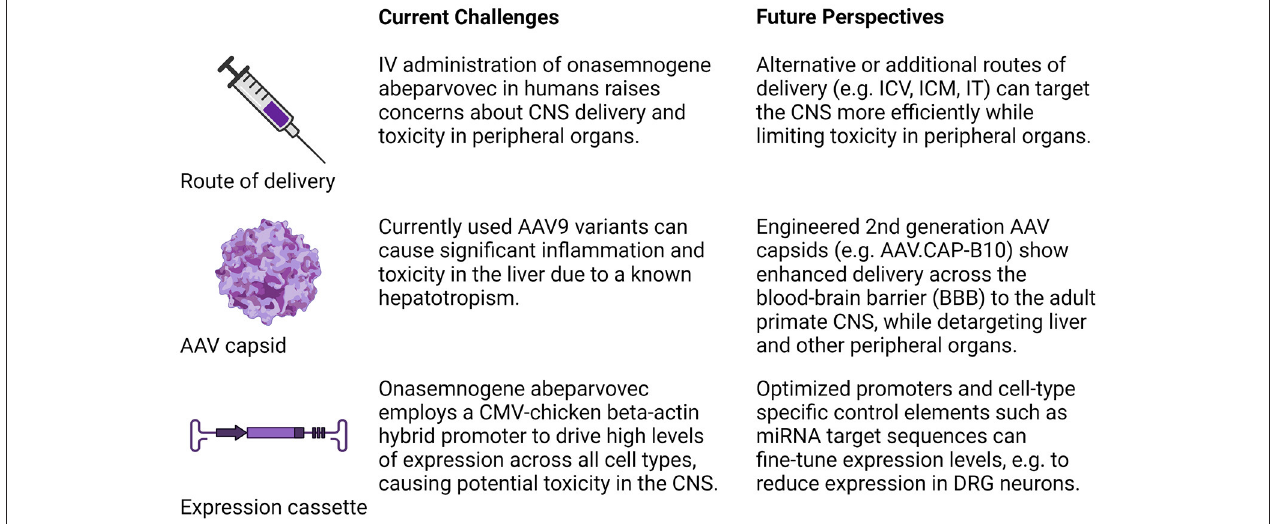
FIGURE 1 | Strategies for increasing therapeutic transduction efficiency and reducing toxicity. Concerns raised by recent studies and future strategies to address these challenges as they relate to the route of administration, the AAV serotype/capsid, and expression construct are summarized. IV, intravenous; ICV, intracerebroventricular; ICM, intracisterna magna, IT, intrathecal; CMV, cytomegalovirus; miRNA, micro-RNA. Figure created with